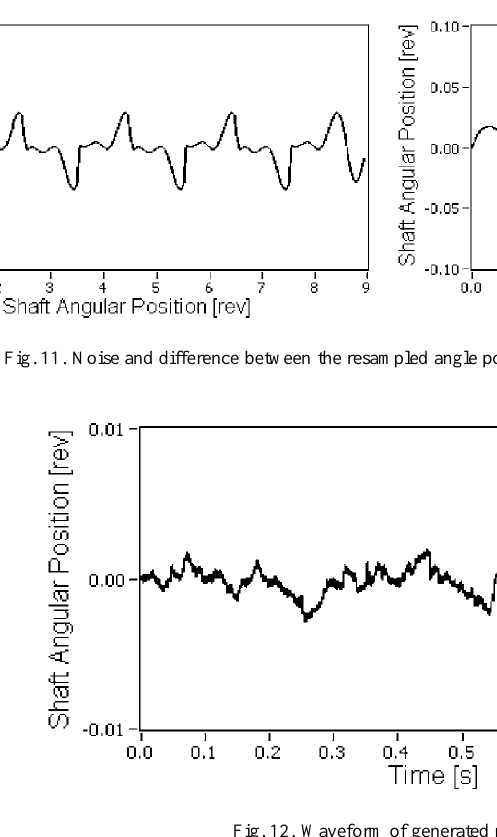
Fig. 12. Waveform of generated